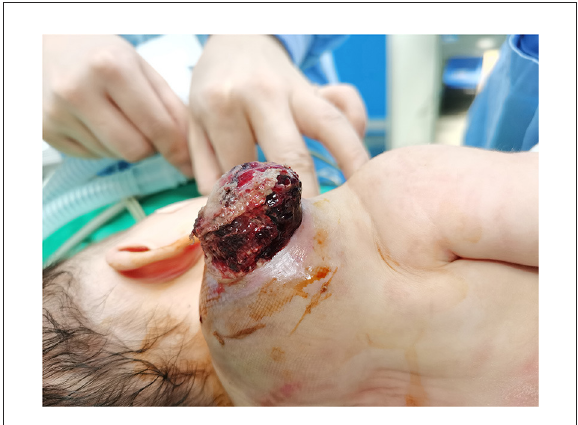
FIGURE2 Tumor after 1 week of cefmenoxime treatment.